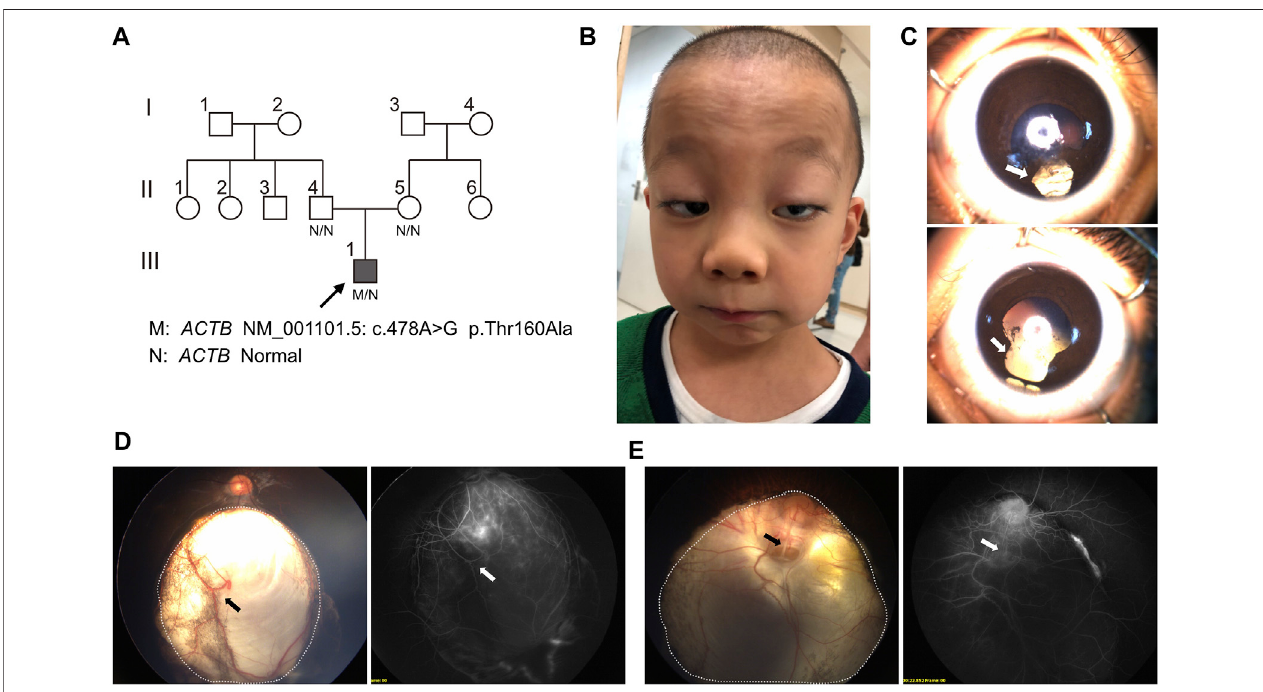
FIGURE 1 | Pedigree and facial, ophthalmological characteristics. (A) Pedigree and genotype of proband (III.3, arrow, fi lled square) and unaffected individuals, which were marked as blank symbols (circles, female; squares, male). (B) Facial anomalies present ptosis, highly arched eyebrow, epicanthal fold, hypertelorism, wide nasal bridge, anteverted nares, long philtrum, thin upper lip, and retrognathia. (C) Bilateral iris coloboma (arrow) with iris pigment adhesion to the anterior lens capsule. (D) Wide- fi eldfundus imaging and fl uorescence angiography showed the chorioretinal coloboma (the area within thedotted line) and large choroidal vessel(arrow) in the right eye. (E) Chorioretinal coloboma (the area within the dotted line) were indicated in the left eye and a pseudoduplication of the optic disc below the real optic disc; angiography revealed vessels radiating from the defect